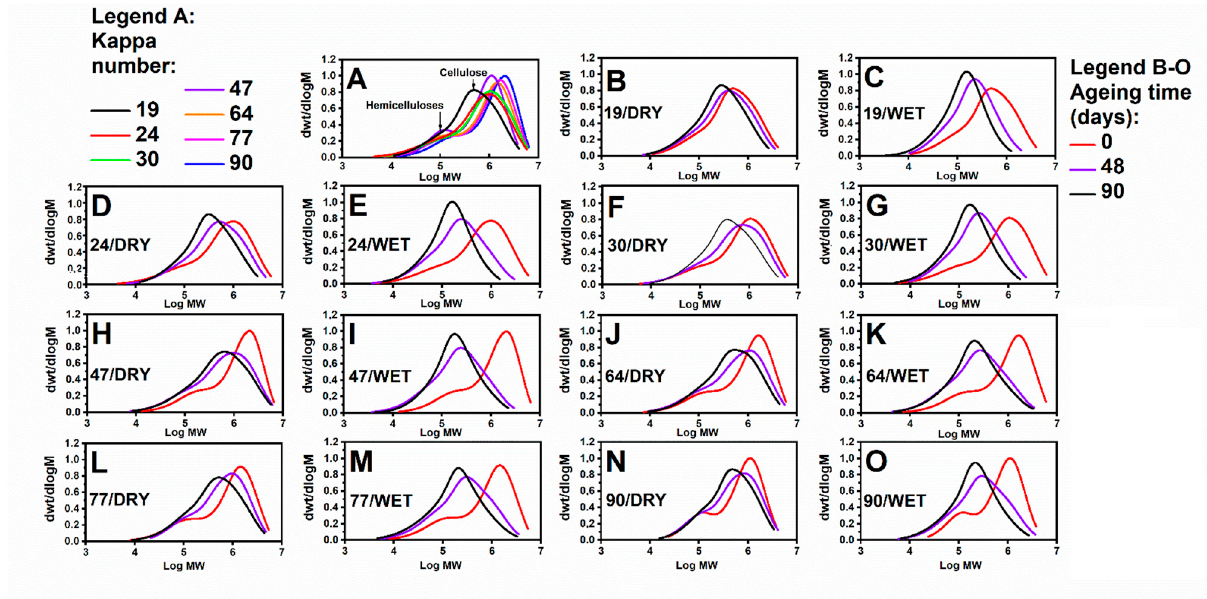
Figure 1. MMD curves of ( A ) unaged paper samples with different lignin contents and ( B – O ) papers containing different amounts of lignin aged in dry and humid atmospheres, DRY and WET, respectively.